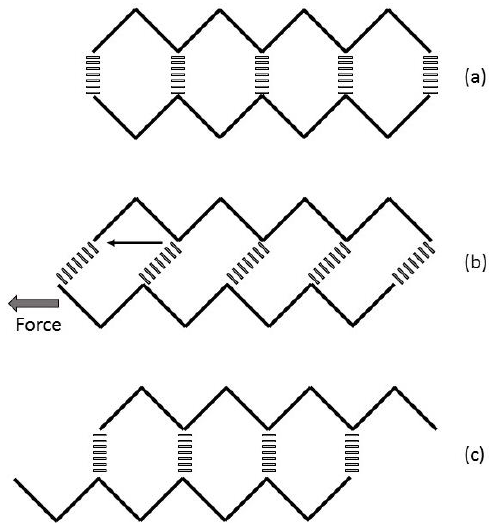
Figure 11. Adaptation of the ‘rip, slip and stick’ model of molecular translation in a lignocellulosic material. ( a ) On the initial hydrogen bonding conformation; ( b ) a force is applied causing the hydrogen bonded network to stretch; ( c ) then after the applied force has ceased, the hydrogen-bonding network reforms in the (new) most favourable position.